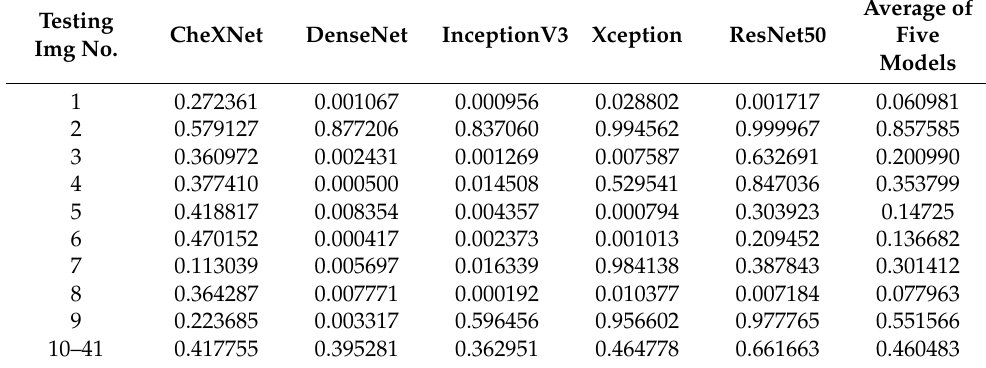
Table 4. Average testing probabilities of five models on RCFV dataset 2.